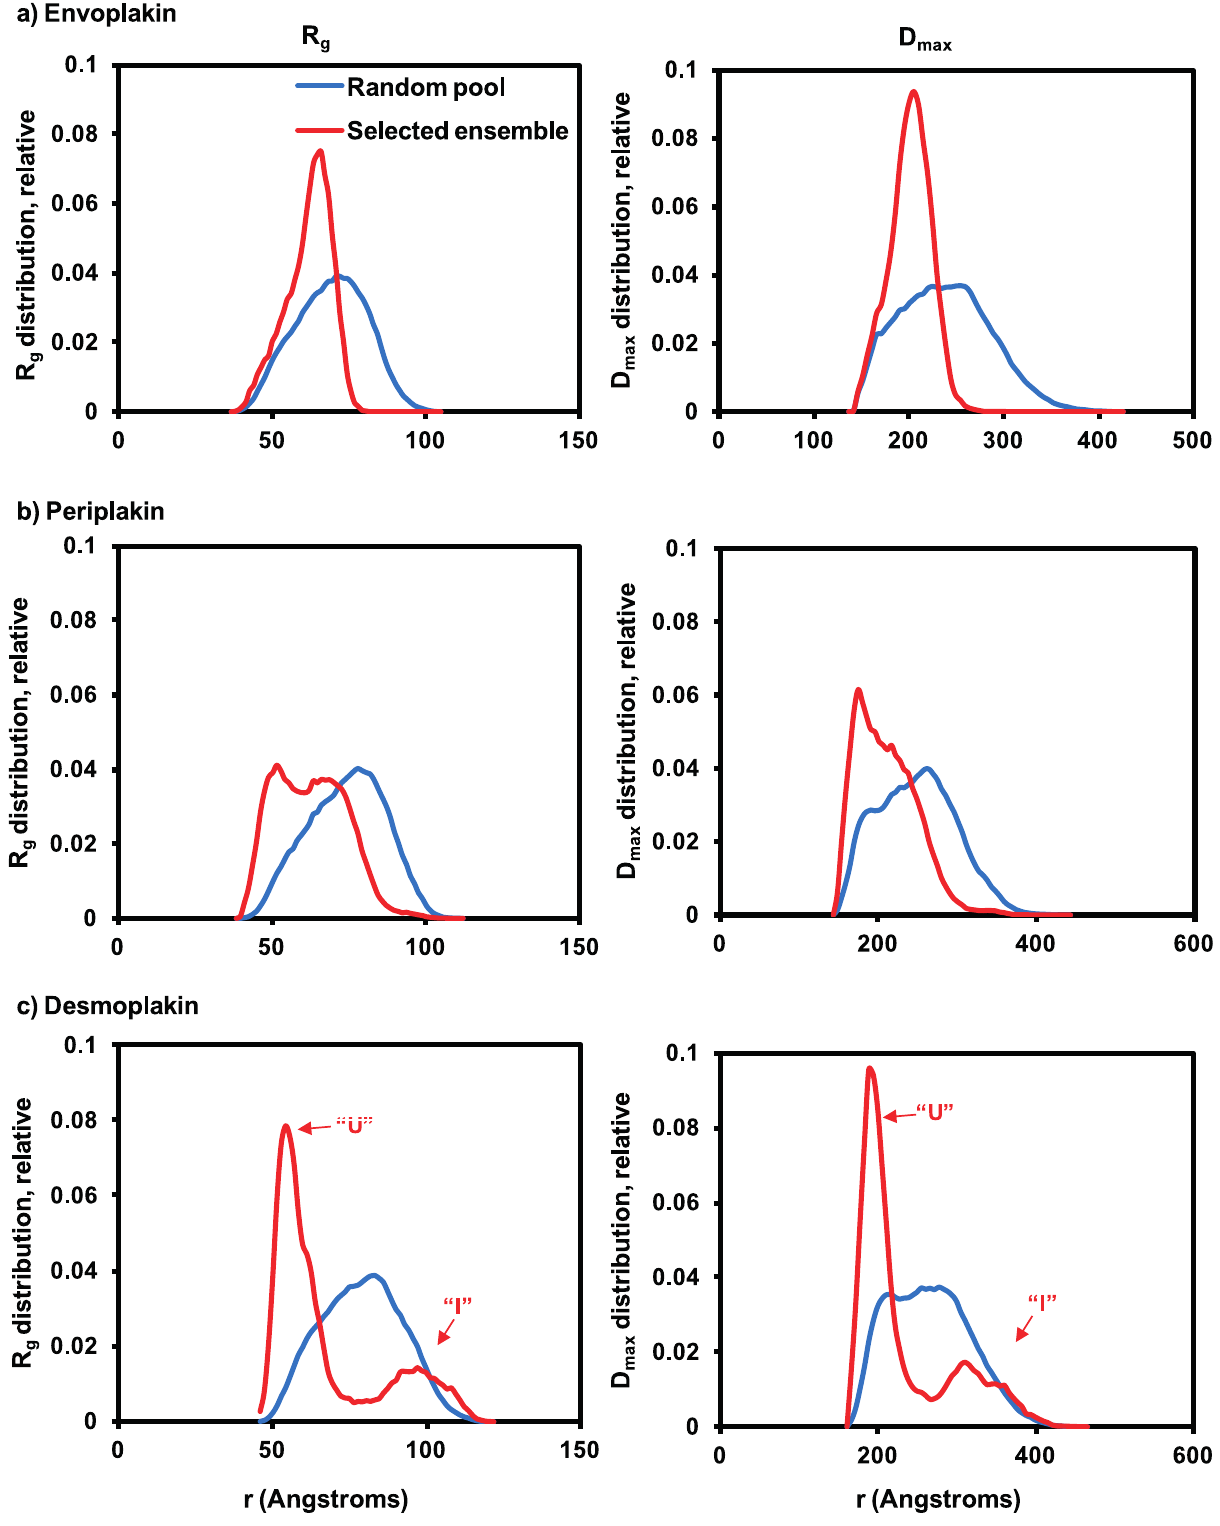
Figure 5. The radii of gyration and maximum particle diameters of plakin domain ensembles. R g and D max values for the pools of 10,000 random structures generated by EOM (blue lines) and ensembles of 50 structures selected by GAJOE (red lines) for (a) envoplakin, (b) periplakin and (c) desmoplakin.